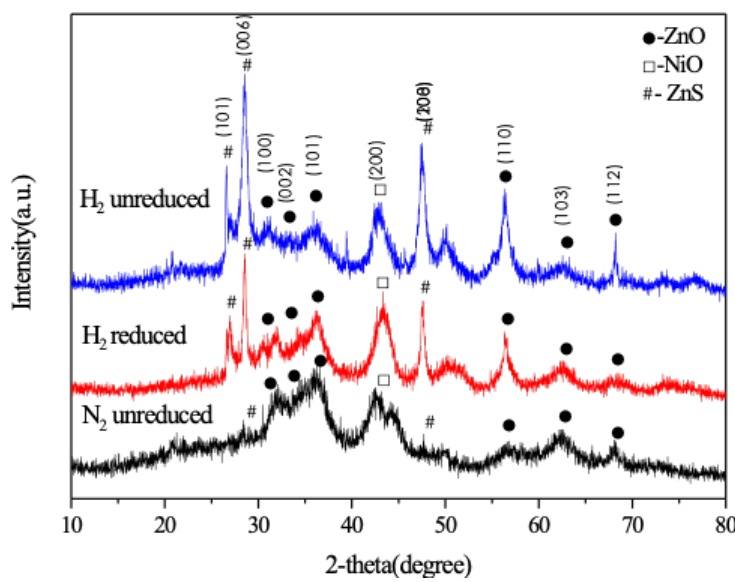
Figure 2. X-ray photoelectron spectroscopy (XPS) analysis of adsorbents after reaction.